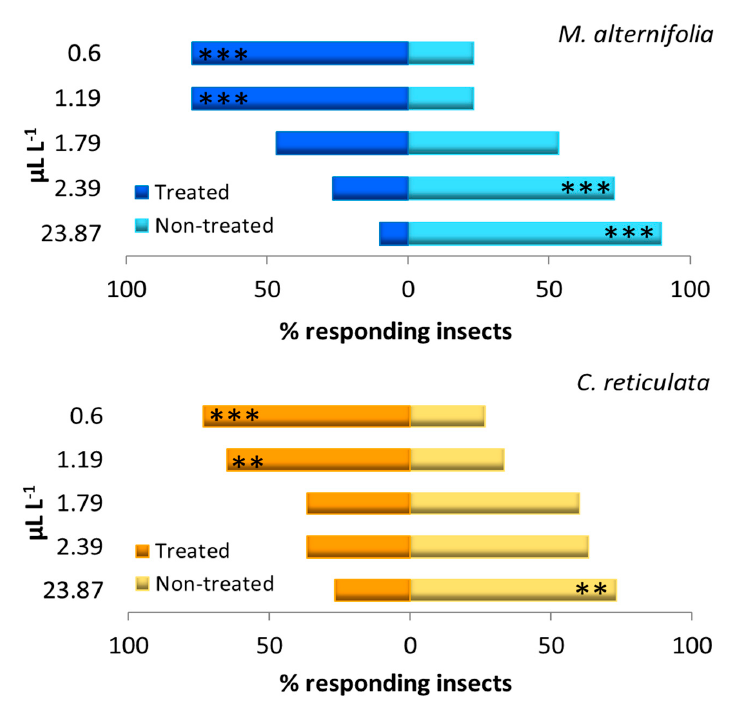
Figure 3. Behavior of adults of Drosophila suzukii in the presence of Melaleuca alternifolia and Citrus reticulata EOs. Histograms represent the percentage of insects that chose the cue or the control chamber. Non-treated, % of insects that chose the control chamber; Treated, % of insects that chose the EO treated chamber. Asterisks indicate significant differences in the number of the choosing insects ( χ 2 test; **, p < 0.01; ***, p < 0.001). The repellence activity was observed at 23.87 mL L − 1 for C. reticulata EO ( χ 2 = 6.533, p = 0.011), and at 23.87, and 2.39 mL L − 1 for M. alternifolia EO ( χ 2 = 19.200, p < 0.001; χ 2 = 6.533, p = 0.011,